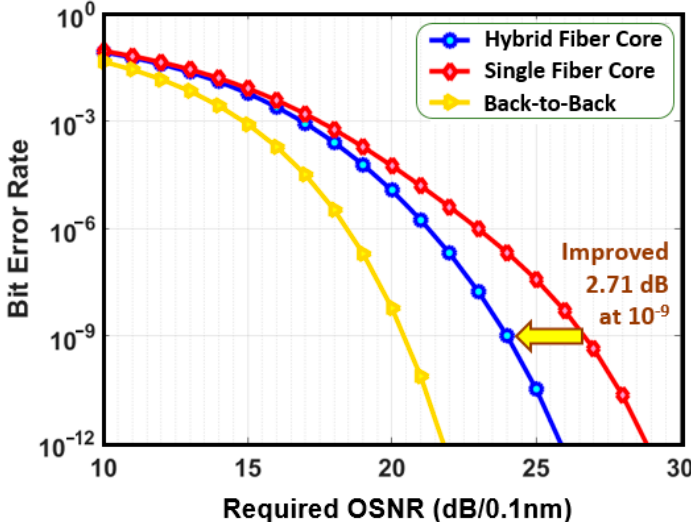
Figure 9. Bit error rate (BER) performance of an 80 Gb/s RZ-DQPSK signal after a 390-km transmission over a three-segment hybrid fiber core structure and a conventional single fiber core structure. The three-segment hybrid fiber core structure had better BER performance and reduced the required OSNR of 2.71 dB at the target BER of 10 − 9 .